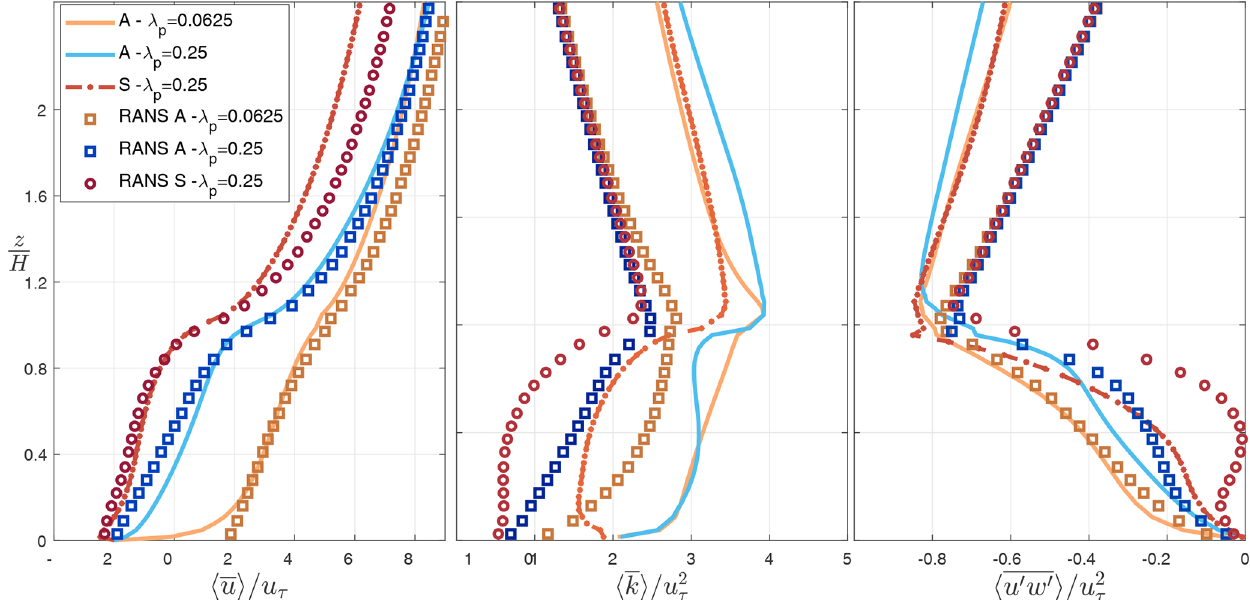
(cid:17) (cid:16) (cid:104) u (cid:48) w (cid:48) (cid:105) /u 2 obtained τ